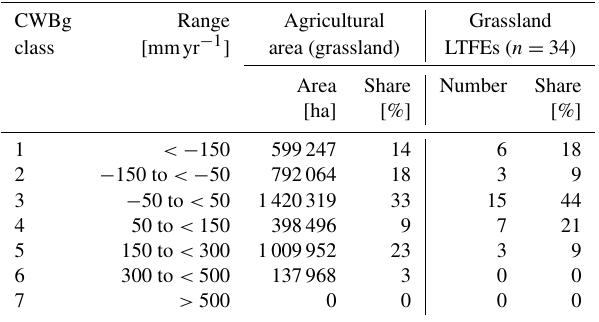
Table 3. Climatic water balance of the growing season (CWBg) classification of agricultural area used for grassland in Germany and the number and share of the LTFEs on grassland in each CWBg class.